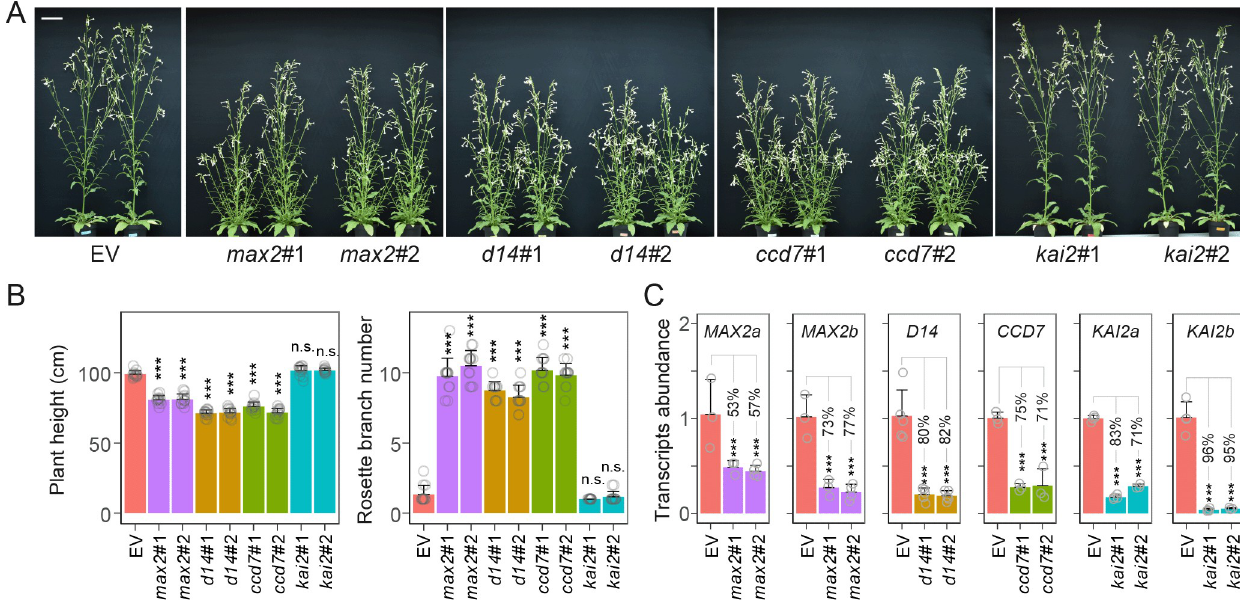
Fig 1. SL-RNAi plants have more branches. (A) Representative branching phenotypes of EV, two independent transgenic lines in which the target genes were individually silenced: max2 #1 and max2 #2, d14 #1 and d14 #2, ccd7 #1 and ccd7 #2, and kai2 #1 and kai2 #2 plants. Scale bar, 5 cm. (B) Plant height and primary branch numbers per plant of indicated plants ( ± SE, n = 12). Branches longer than 5 cm were counted. (C) Silencing efficiency of target genes. Relative transcript abundance of MAX2a and MAX2b in axillary buds of EV, max2 #1, and max2 #2 plants; D14 in axillary buds of EV, d14 #1, and d14 #2 plants; CCD7 in seedlings of EV, ccd7 #1, and ccd7 #2 plants; KAI2a and KAI2b in leaves of EV, kai2 #1, and kai2 #2 plants ( ± SE, n = 3–4) ( ��� P < 0.001; two- tailed Student t test). Values for graphs (B) and (C) are listed in S1 Data. ccd, carotenoid cleavage dioxygenase; d14, dwarf 14; EV, empty vector; kai2, karrikin insensitive 2; max2, more axillary growth 2; n.s., not significant; RNAi, RNA interference; SL, strigolactone.